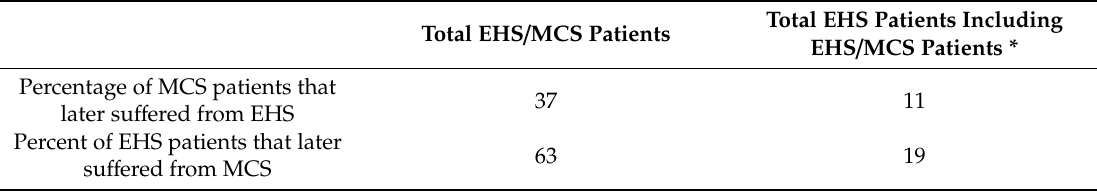
Table 9. Percentage of MCS patients who later su ff ered from EHS and vice